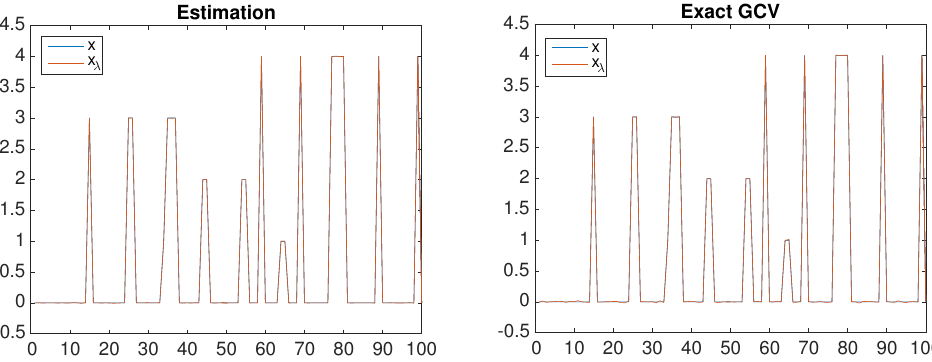
Figure 1. Solution of the Shaw test problem via an estimation of GCV ( left ) and the exact GCV ( right ).